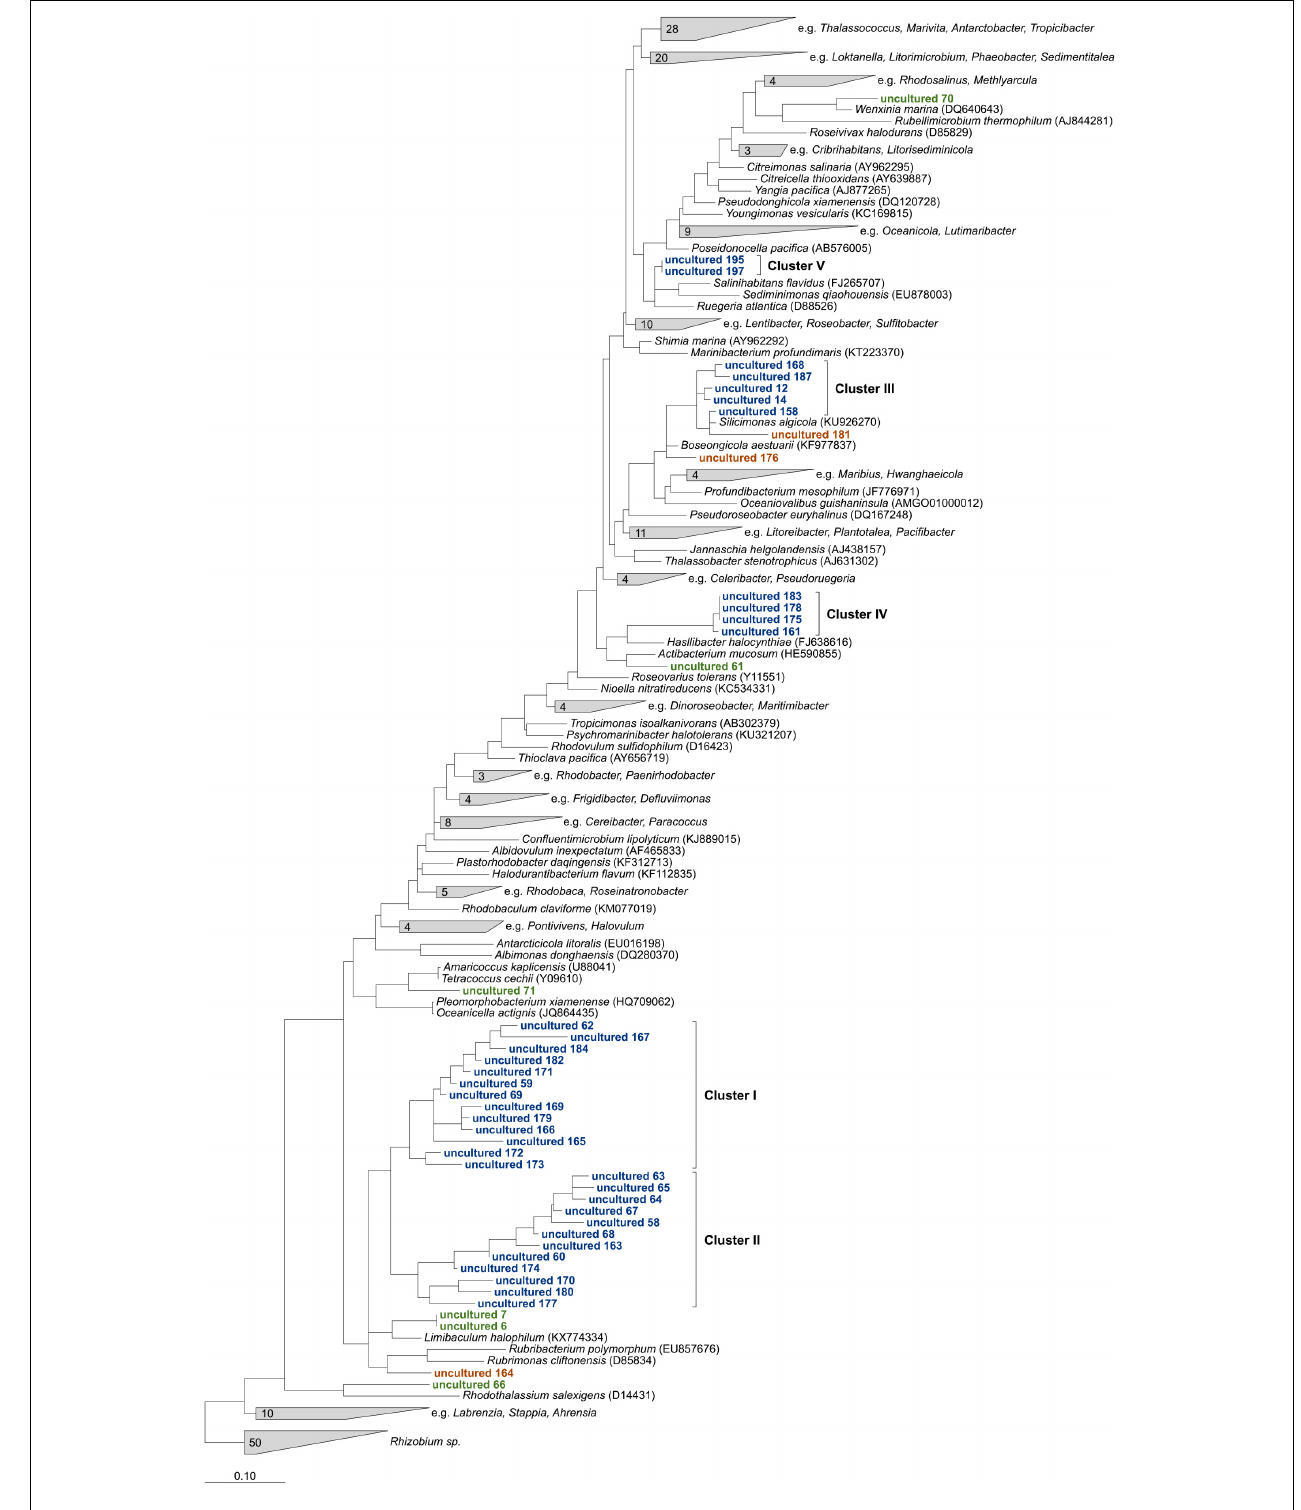
FIGURE 3 | Maximum likelihood tree highlighting the position of consensus sequences of the 45 most abundant Rhodobacteraceae -OTUs assigned as “uncultured” relative to other members of the family. The tree was created using ARB (Ludwig et al., 2004) and rooted by sequences of the genus Rhizobium . To keep the tree clear and readable, type strains that were not related to the “uncultured” sequences were collapsed into single groups. Sequences in green could clearly be related to next relatives, orange ones changed positions in comparison to neighbor joining and maximum parsimony trees. Blue sequences always formed consistent clusters.